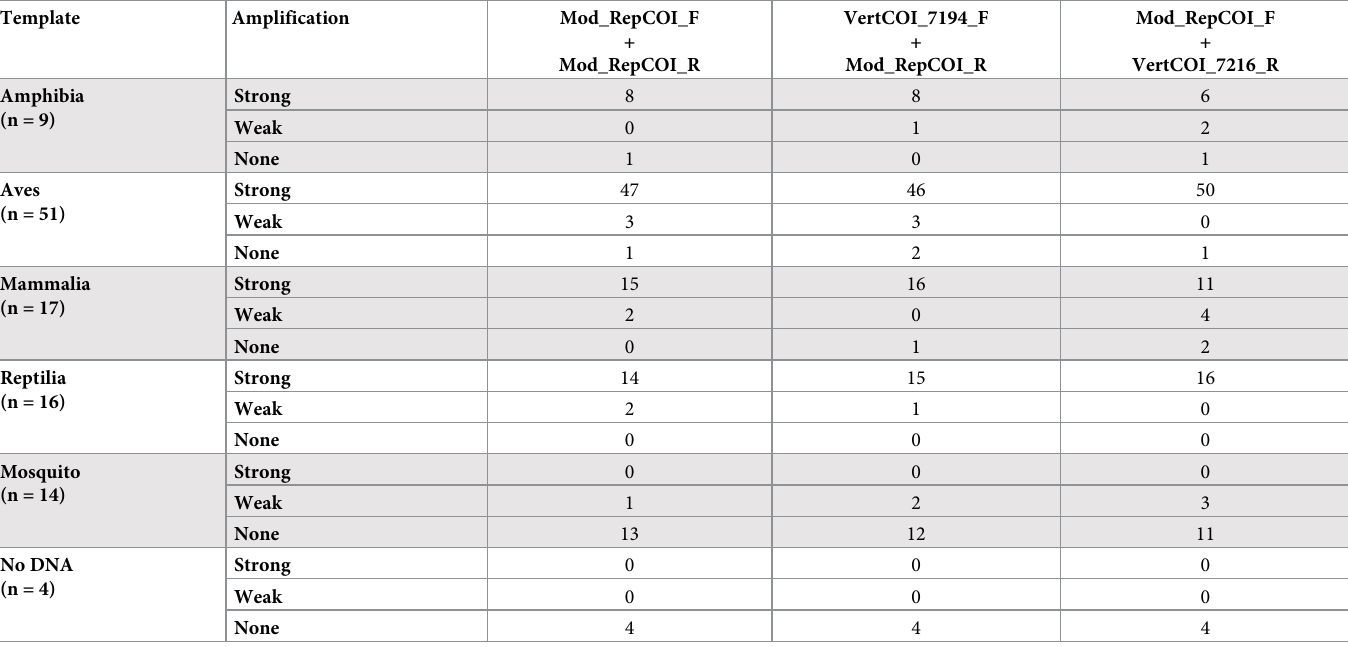
Table 3. Amplification success of vertebrate host mosquito only DNA templates and no DNA